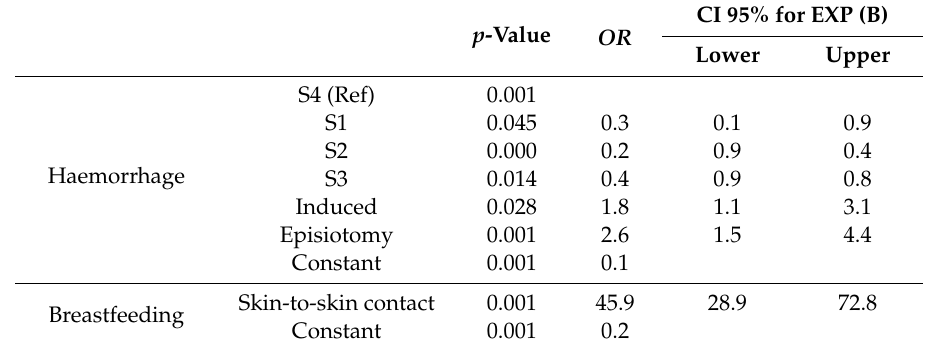
Table 3. Multivariate logistic regression between haemorrhage, breastfeeding and related covariables ( N =